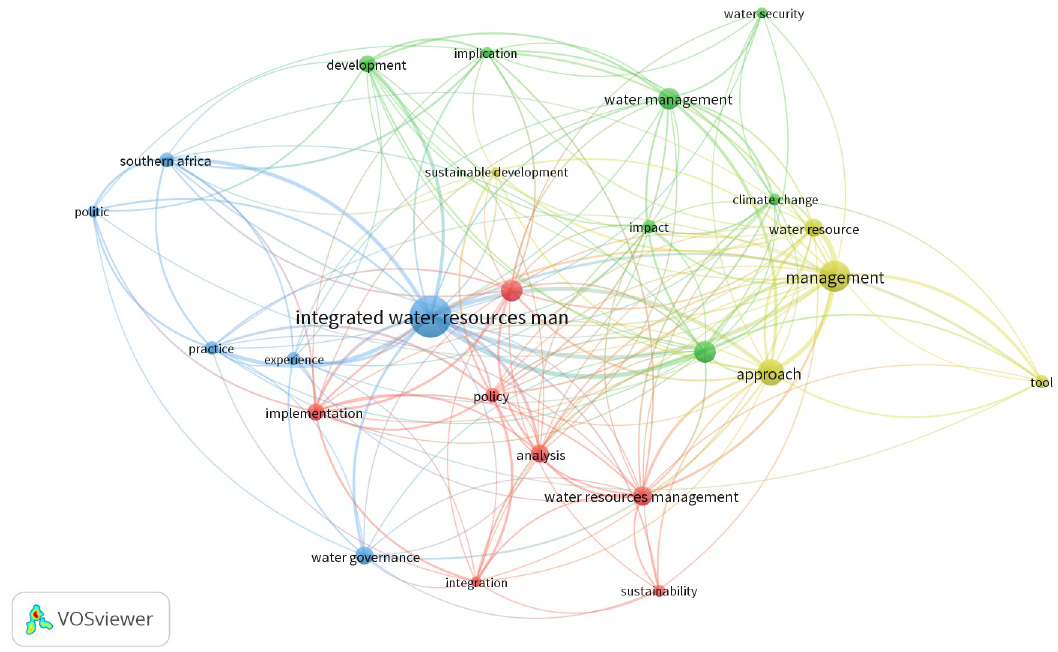
Fig 2. Extracted and converging themes from the coded data